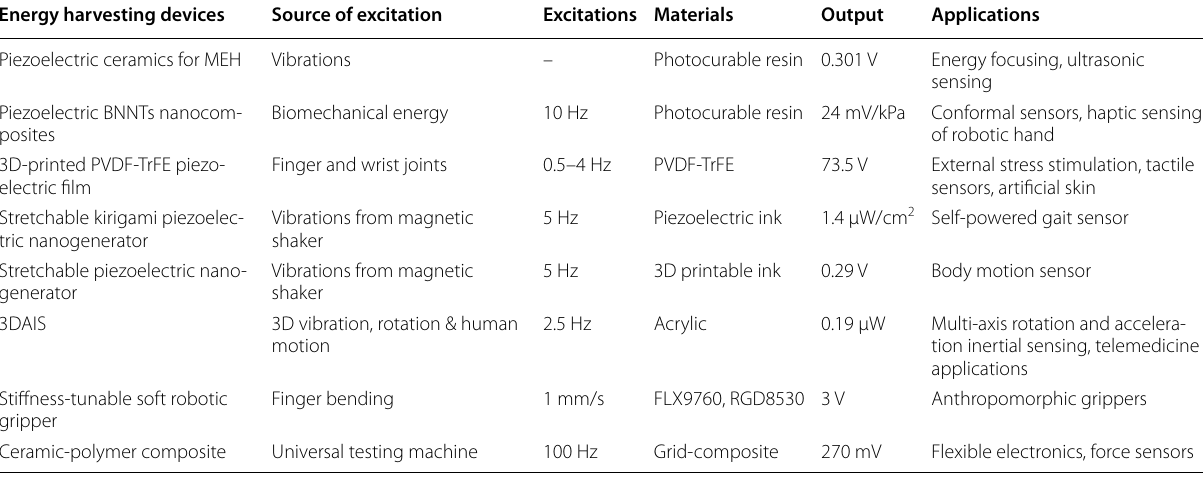
Table 4 Piezoelectric nanogenerator based 3D printed energy harvesting devices, their output energy capacities and